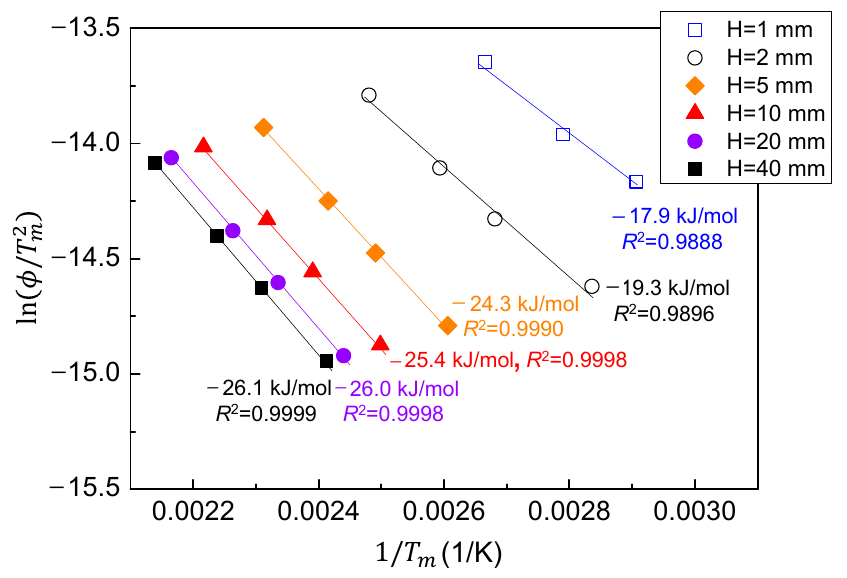
Figure 8. Choo–Lee plot for different specimen geometries (H = 1, 2, 5, 10, 20, 40 mm), showing the increase in deactivation energy with the decrease in H . Notably, no local peak was identified for H = 1 mm at a heating rate of 200 K/h. Table 1. Results of the linear fitting for the Choo–Lee plot for different specimen geometries.